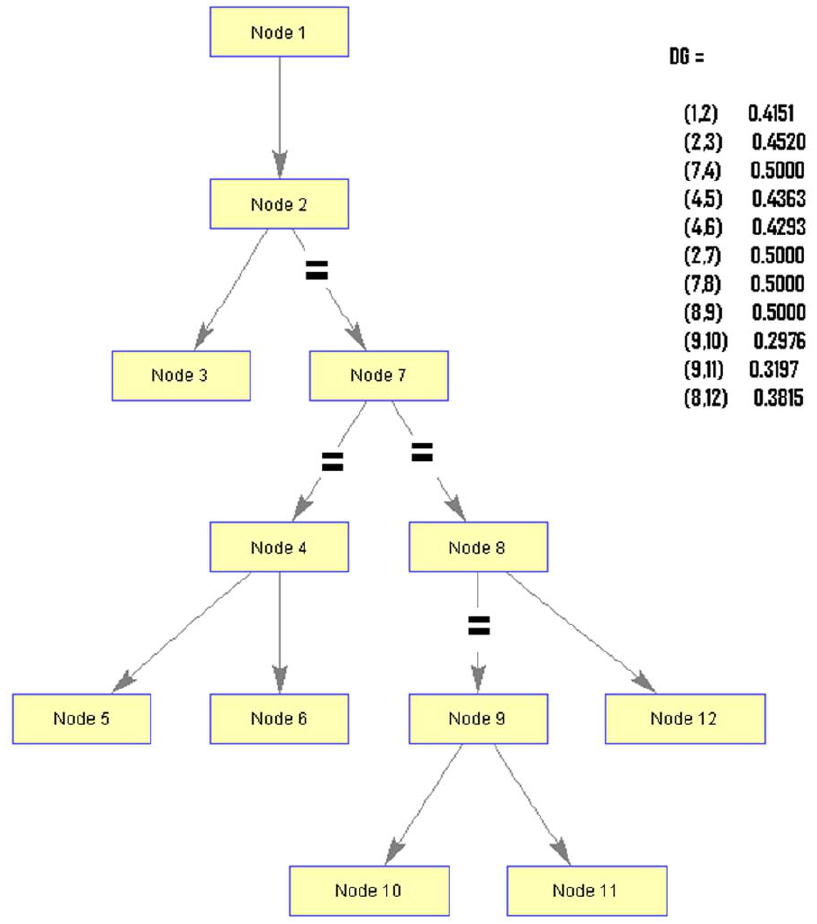
Figure 4. Distance of the phylogenetic tree of 12 nodes (developed by MATLAB 7.3).